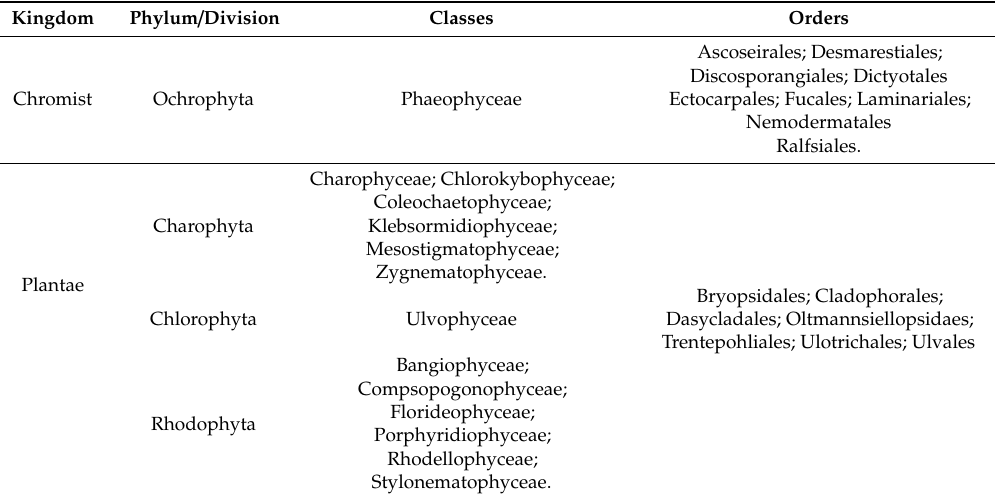
Table 1. Phylogenetic summary of the most common